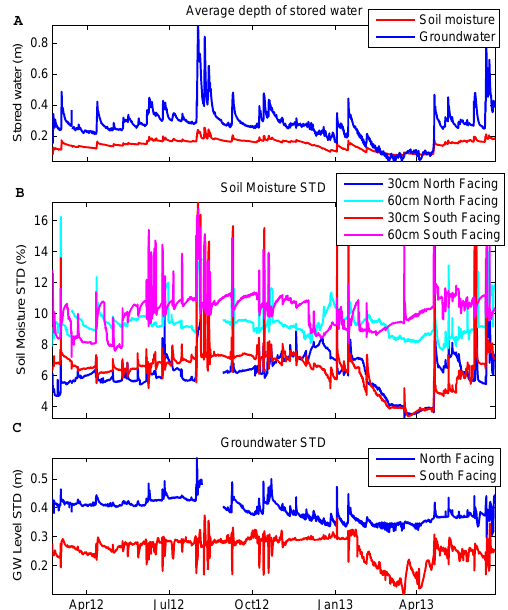
Figure 7. (a) Average depth of water stored in the catchment as soil moisture and groundwater. (b) Spatial standard deviation of soil moisture values, by aspect and depth. (c) Spatial standard deviation of groundwater levels, by